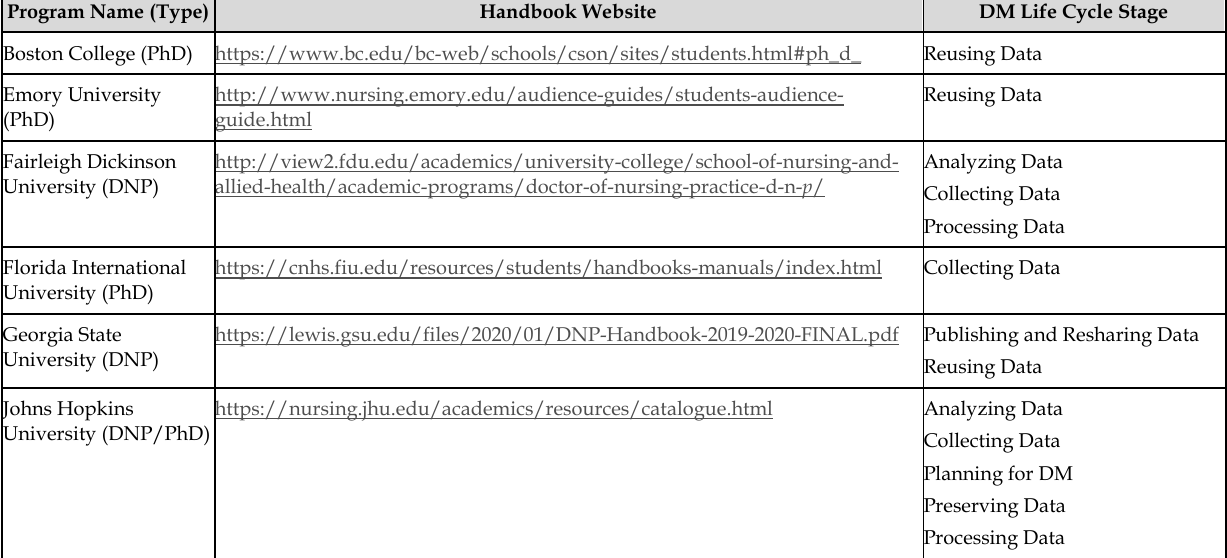
Table 1 Great examples in programs and